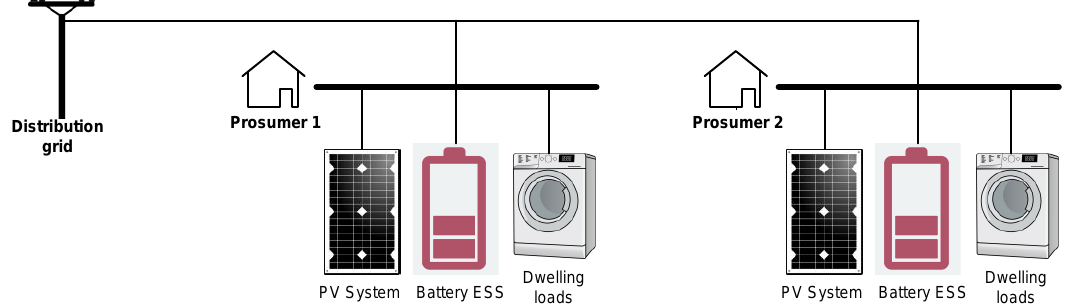
Figure 1. Schematic of the microgrid under study.